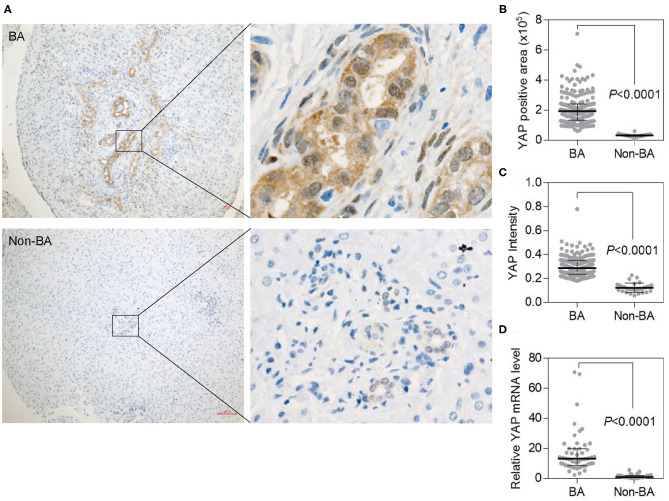
YAP expression is upregulated in BA livers. (A) YAP protein expression assessed by IHC staining in BA (upper panel) and non-BA (bottom panel) livers. Scale bar: 100 μm. (B) Quantification of YAP positive area in (A). (C) Quantification of intensity of YAP IHC signals in (A). (D) The mRNA level of YAP in BA and non-BA livers measured by quantitative PCR.